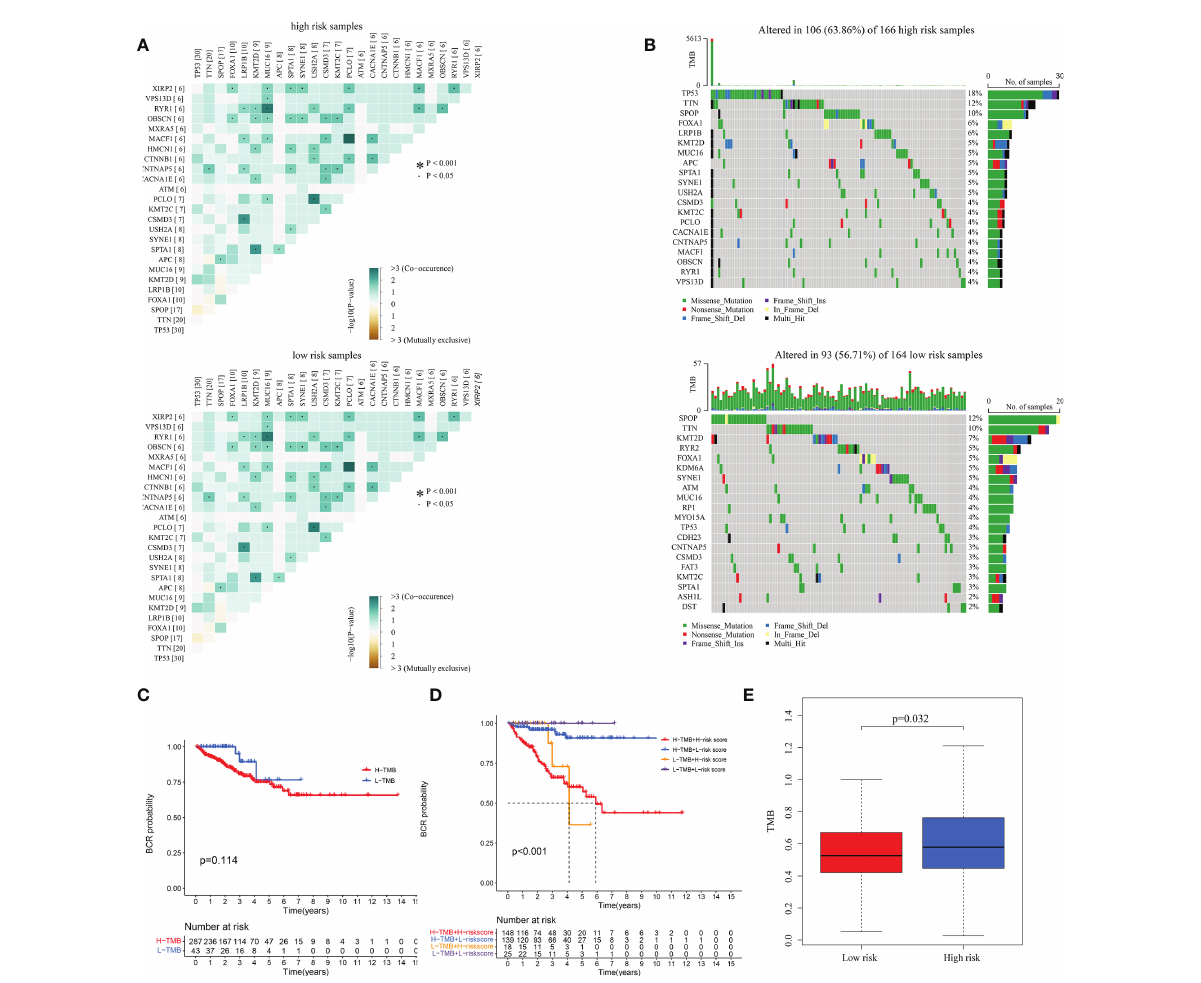
FIGURE 9 The correlation between TMB and the signature in TCGA. (A) The heatmaps of the correlation between some common mutated genes in both high-risk and low-risk groups. (B) Waterfall plots mutated genes in both subgroups. (C, D) KM curves of patients with different TMB and risk levels. (E) The differential analysis of TMB between different risk